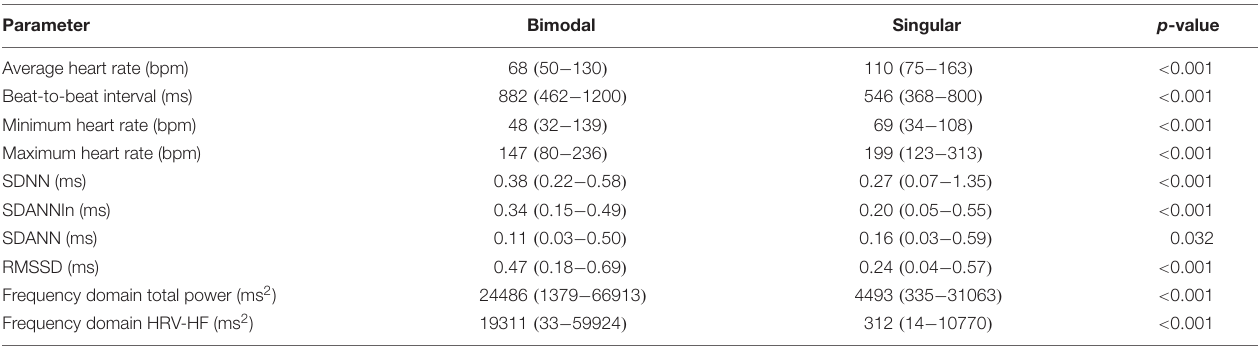
TABLE 2 | Comparisons of bimodal versus singular histogram distributions within dog and clustered versus branched beat-to-beat interval patterns between dogs. (A) Within dog ( n = 128) (paired data) comparison of an hour with a large paucity of beats resulting in a bimodal distribution and an hour with a small paucity of beats characterized as a single distribution. Heart rate variability parameters corrected for heart rate (see text). Data shown as median (range) and p -value from Wilcoxon Signed Rank Test with Bonferroni